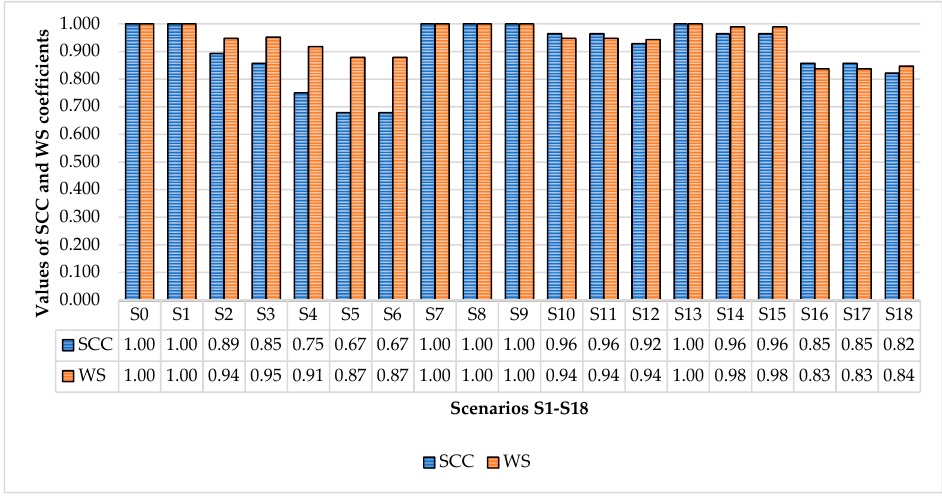
Figure 9. SCC and WS rank correlation coefficients in sensitivity analysis.